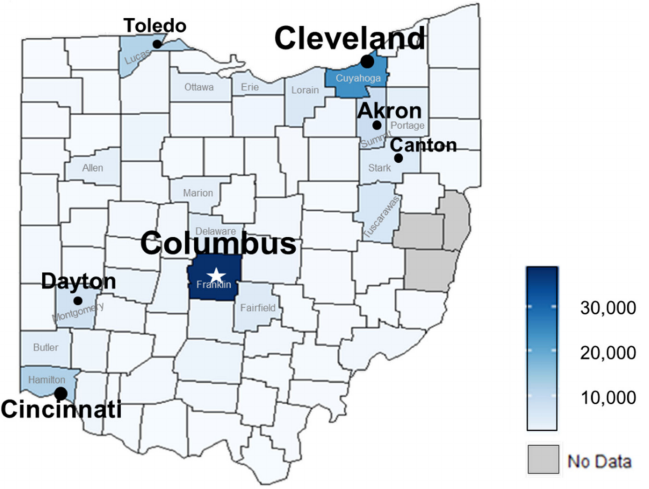
Figure 4. Heat map of estimated total number of bed bug treatments performed by licensed compa- nies in each Ohio county during 2016. The darkest shade of blue indicates a maximum threshold of approximately 38,000